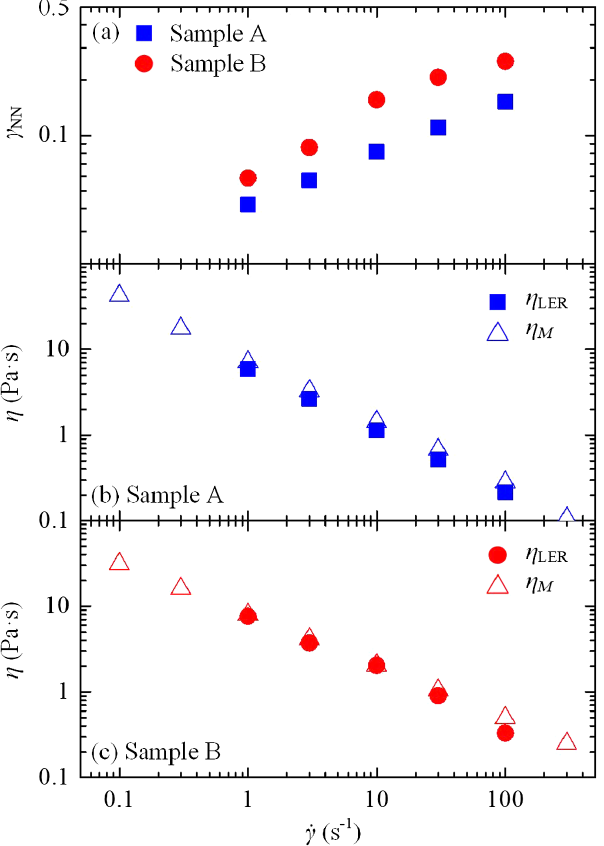
FIG. 12. (a) Experimental γ found through Eq. (29) for both NN samples. (b) Comparison between the microscopic shear viscos- ity η and the macroscopic shear viscosity η for sample A . FIG. 13. (a) Experimental g − 2 2 ð r Þ of sample A at _ γ ¼ 1 , 10, and M LER 100 s − 1 . The magnitude of g − 2 (c) Comparison between η and η for sample B . M LER range of LER ξ (symbols) of sample A estimated from exper- imental g − 2 2 ð r Þ . Here, we do not plot the result at _ γ ¼ 1 s − 1 since its value is unreasonably large. The solid line denotes the fit with the power law ξ ∝ _ γ − ν , where ν is found to be